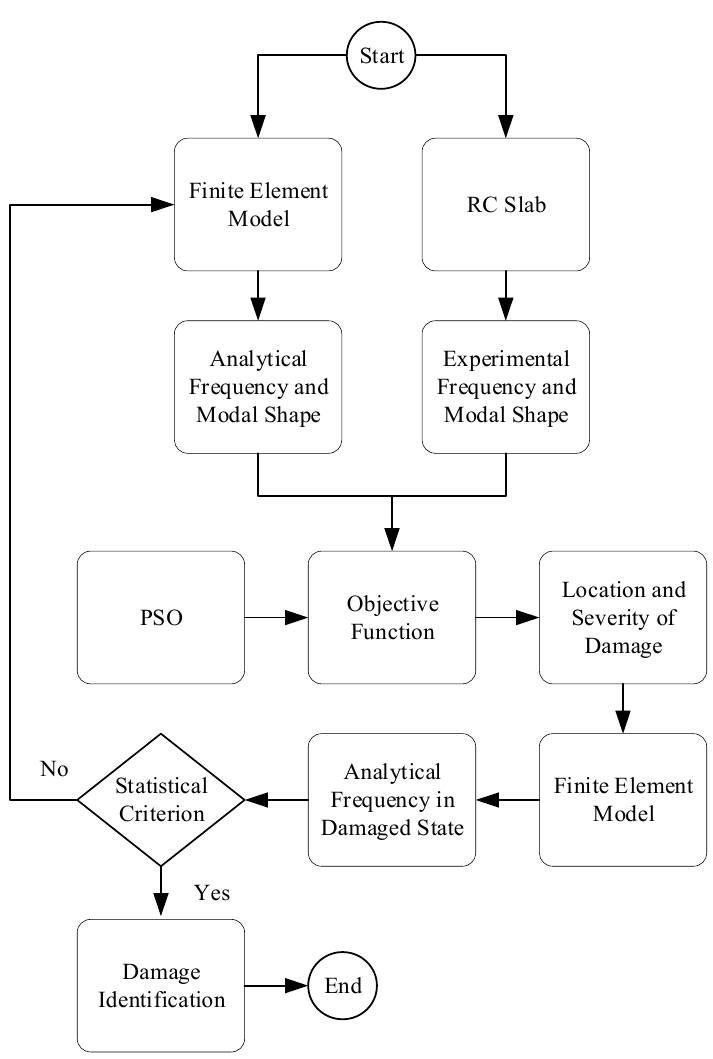
Figure 16. The flowchart of damage identification.